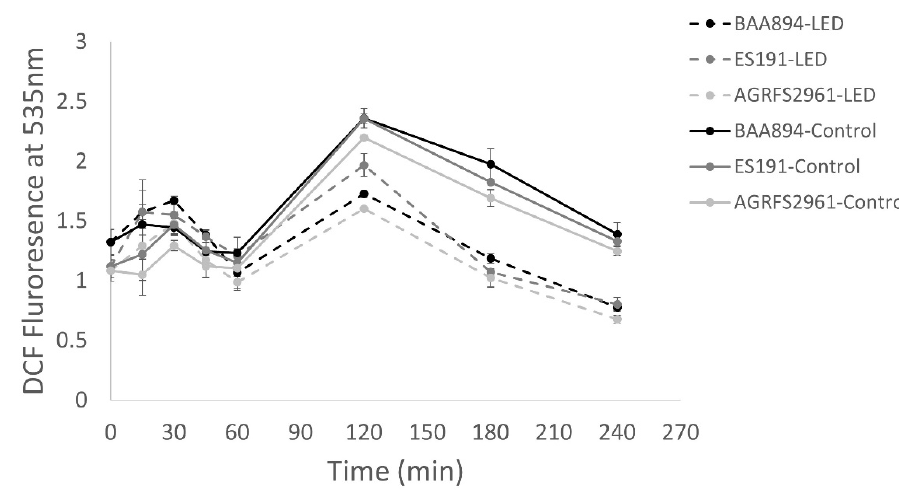
Figure 3. Endogenous ROS detection by DCFH-DA test during 4 h of light application.